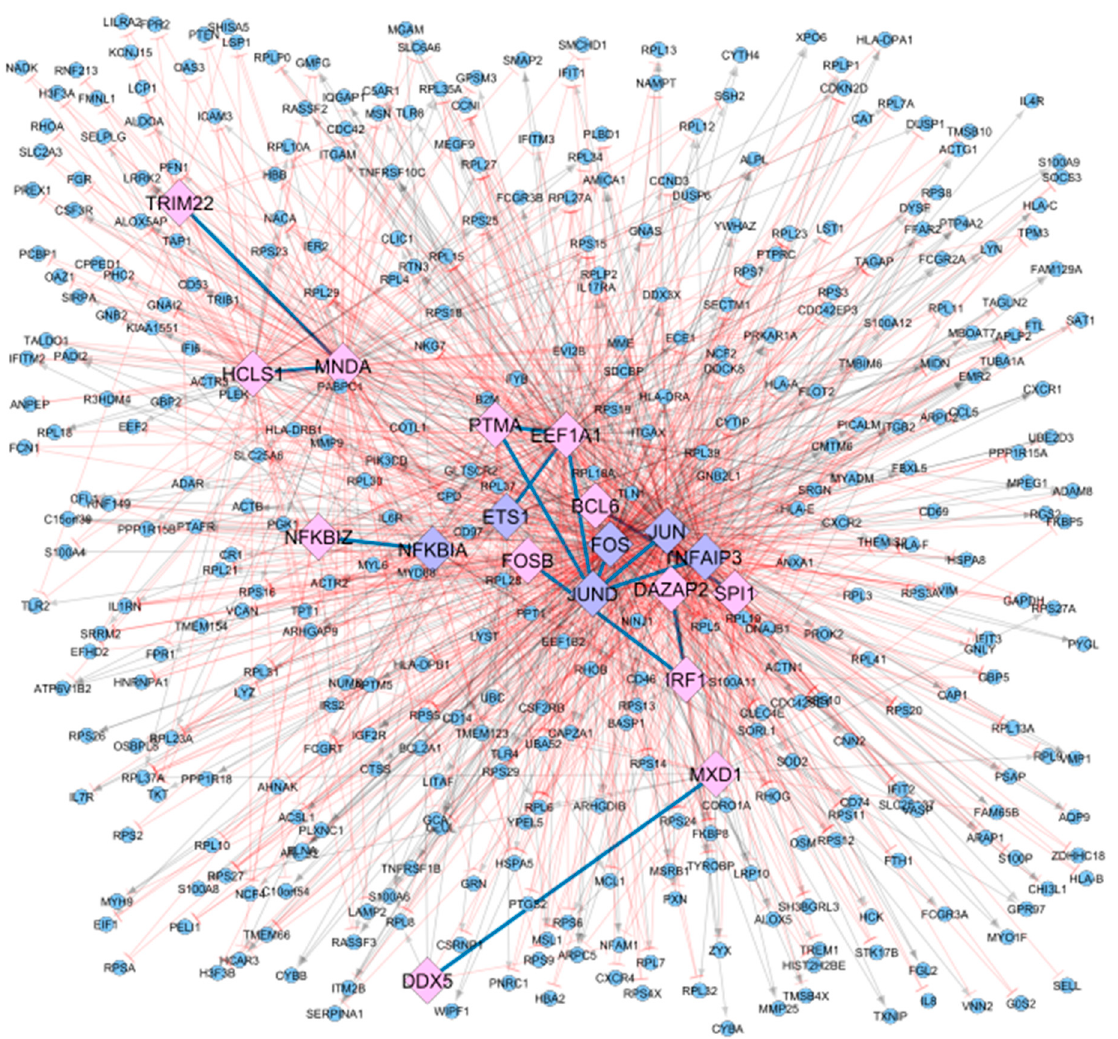
Figure 2. Co-regulatory network inferred using the tool CoRegNet and the matrix of normalised counts from the transcriptomic dataset (GSE117769). The dataset used included data from 90 samples (48 Controls and 42 RA patients). Matching TFs from CoRegNet with the RA map are depicted using a diamond shape and coloured in purple (6), while non-matching TFs are depicted in a diamond shape and coloured in pink (13). CoRegNet target genes are coloured in blue (373) and have round shapes. Inhibitions are represented with blunt red arrows, and activations are represented with grey arrows.